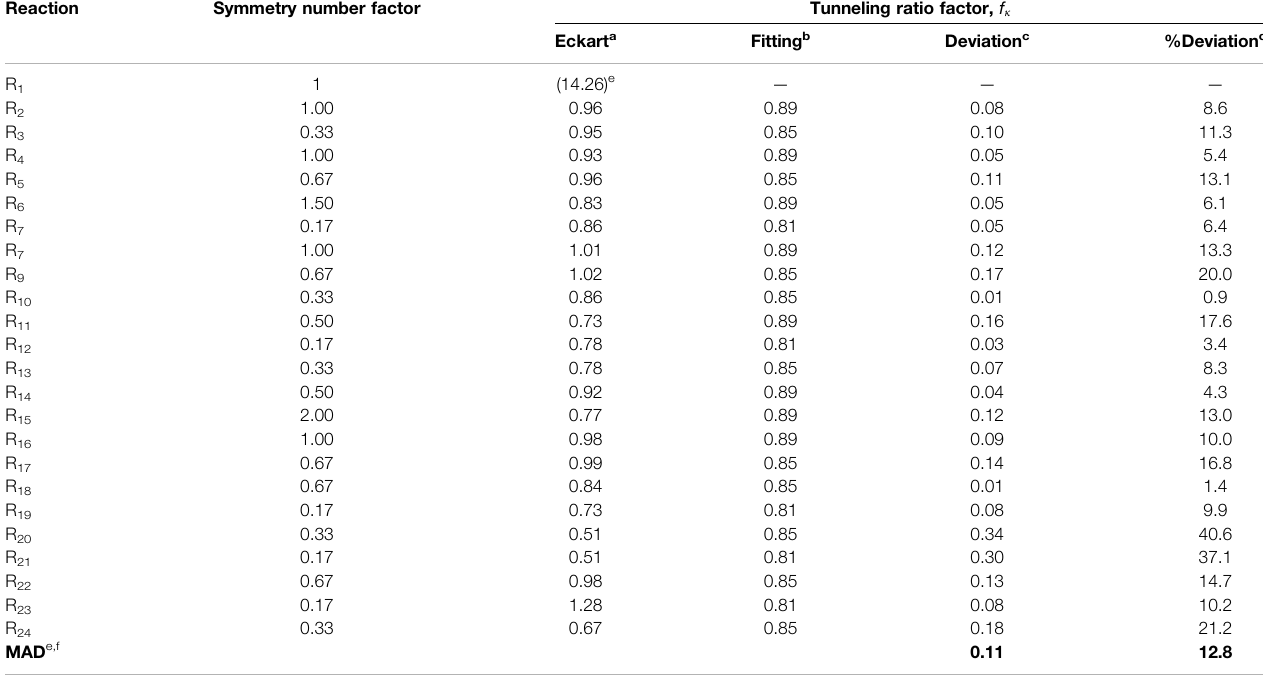
TABLE 4 | Symmetry number f σ and tunneling f κ RC-TST coef fi cients at T = 300K. Reaction